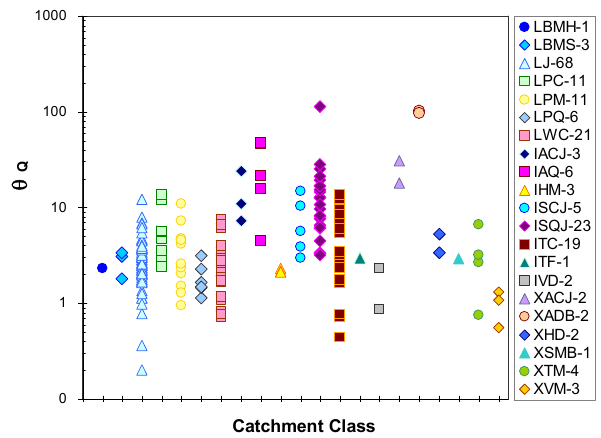
Fig. 6. The parameter θ of the mixed gamma distribution for total streamflow grouped by catchment class and showing the number of catchments per class (L, I, and X denote low to high seasonality in P) .